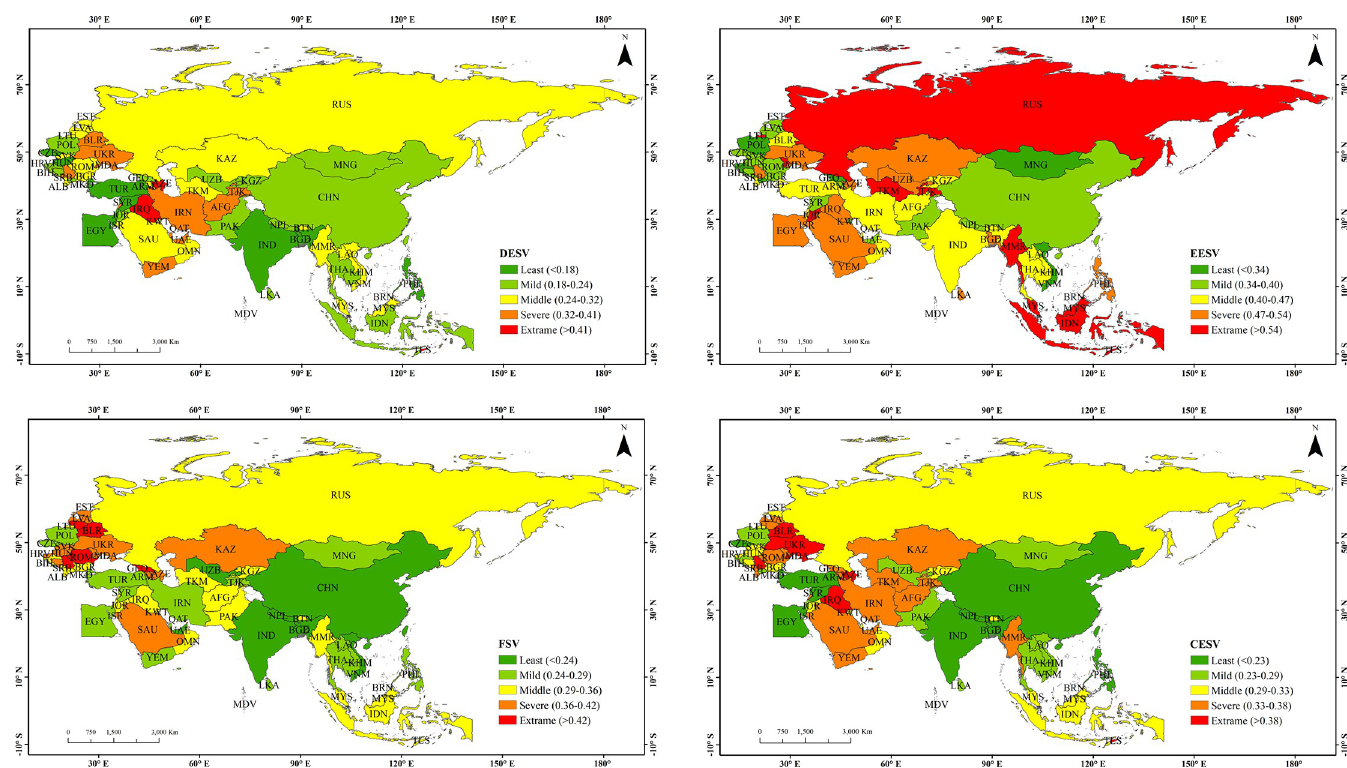
Fig 2. Spatial patterns of economic system vulnerability of the BRI countries (a. DESV, b. EESV, c. FSV, and d.